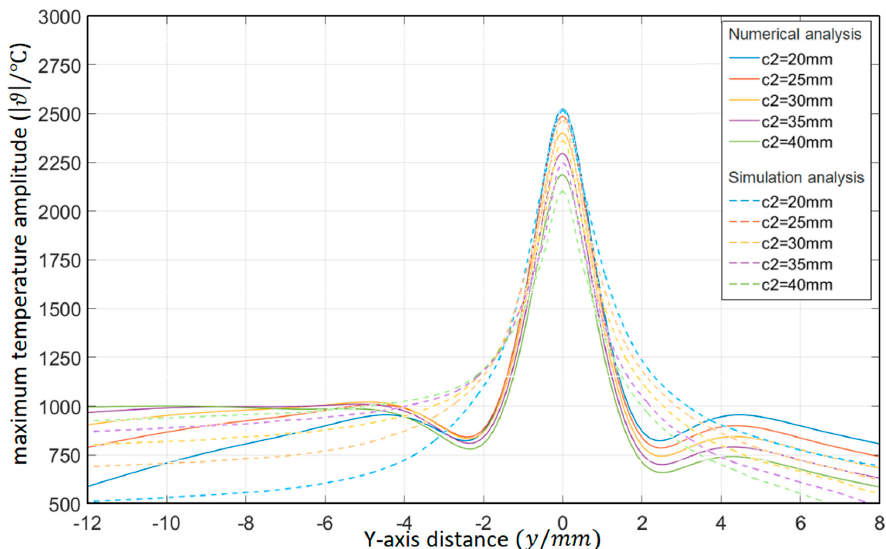
Figure 6. Surface temperature distribution diagram of platinum rhodium bushing: ( a ) c 2 = 20 mm;